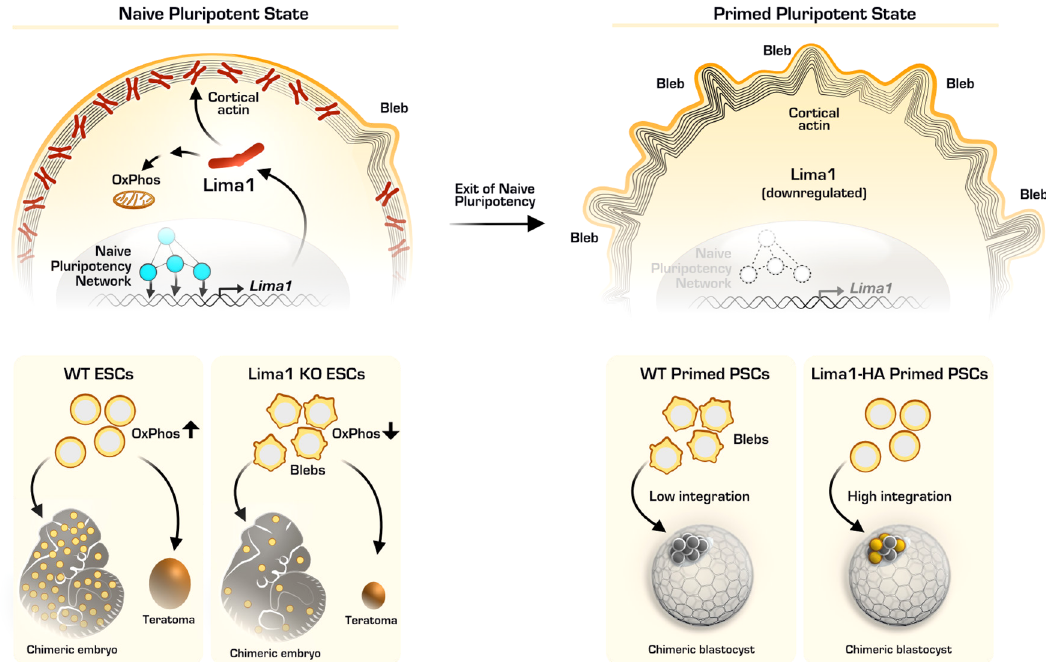
Fig. 9 Lima1 mediates the pluripotency control of membrane dynamics and cellular metabolism. Lima1 expression is promoted by the naïve pluripotency transcription factors, which occupy the Lima1 promoter region. In turn, the cytoplasmic pool of dimeric Lima1 proteins bound to the actin fi laments stabilises the cortex, thereby suppressing the formation of membrane blebs in naïve pluripotent cells. Lima1 is also involved in the mitochondrial energetics and is crucial for growth of teratomas and embryonic chimerism of ESC. Upon exit of naïve pluripotency, the naïve transcriptional circuit is dismantled and Lima1 is downregulated, resulting in the formation of membrane blebs. Accordingly, ectopic expression of Lima1 in mouse and human primed pluripotent cells suppresses membrane blebbing and enables the incorporation of the primed cells into murine pre-implantation embryos. OxPhos, oxidative phosphorylation; naïve pluripotency transcription factors are marked in blue; donor cells are marked in